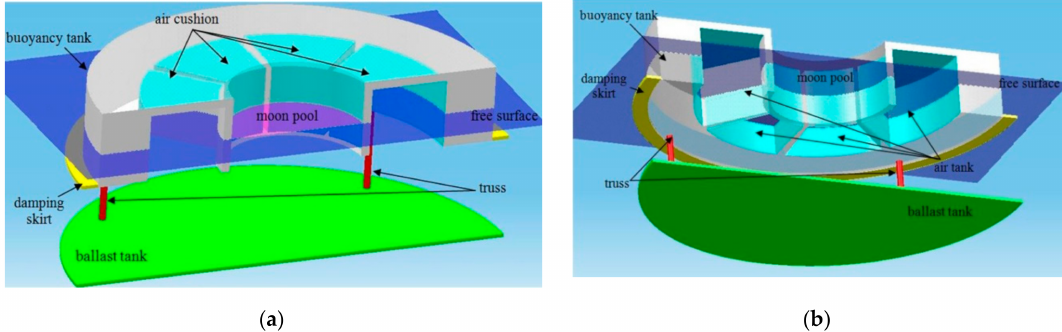
Figure 3. Schematic diagram in 3D of the zero-pressurized air-cushion-assisted barge platform. ( a ) Top side view; ( b ) bottom side